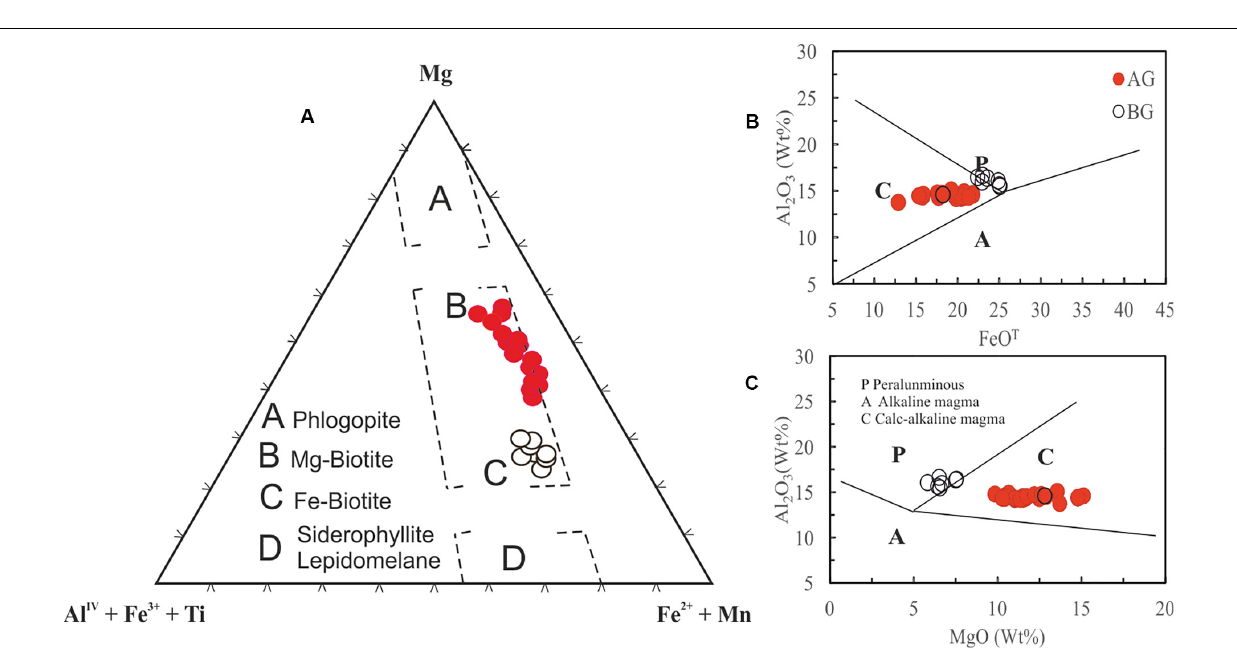
components, including progressive increase in the activity of H 2 O (Chappell et al., 1998). Barium variation in Batié granite illustrates that the compositional variation resulted from fractional crystallization. The Ba contents in the AG increased up to 2,000 ppm before decreasing. In the BG, Ba decreases